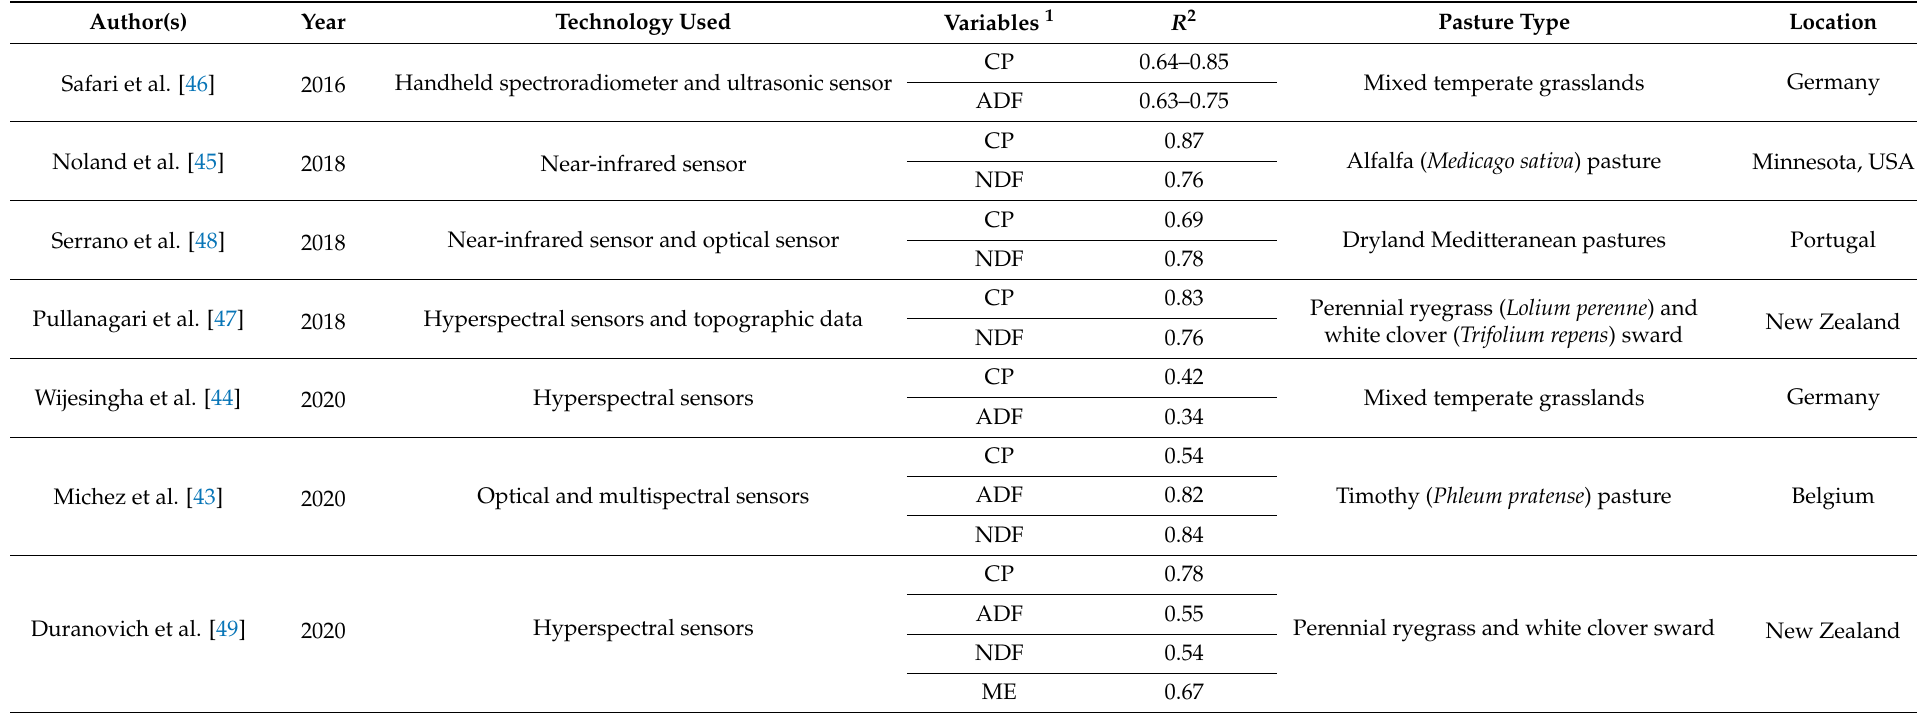
Table 2. Studies using proximal sensing technologies to assess forage nutrient concentrations in pastures or